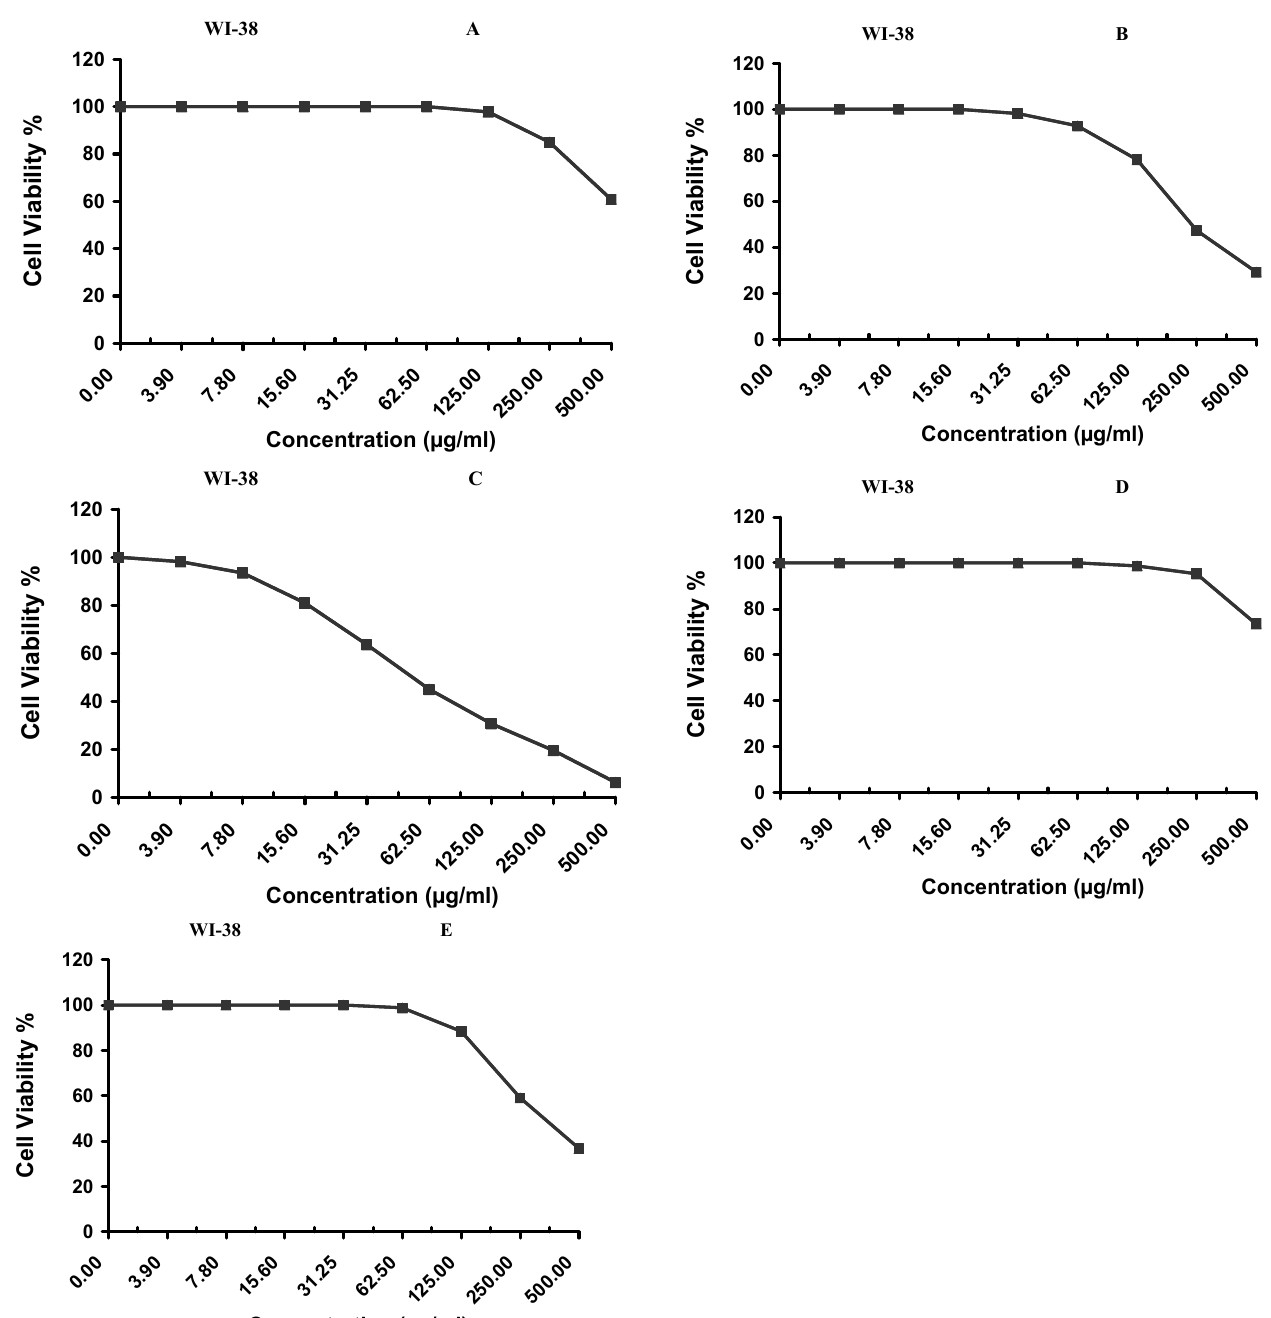
Figure A6. The percentage of cell viability of normal fibroblast cell lines (WI-38) upon treatment with serial concentrations of ( A ) unloaded PLGA NPs, ( B ) PLGA-Cf-F 1 , ( C ) NPs, PLGA-Cf-F 2 , ( D ) NPs, PLGA-Cf-F 3 and ( E ) the free coffee extract.